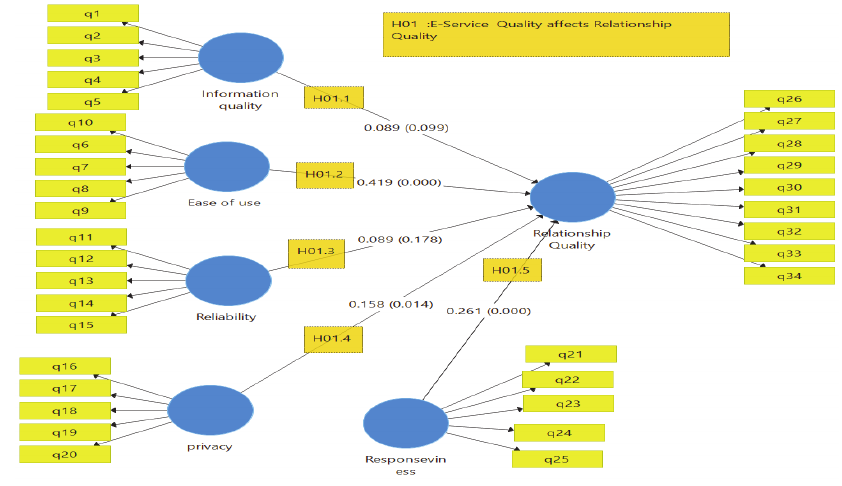
Fig. 4. PLS Structural Model